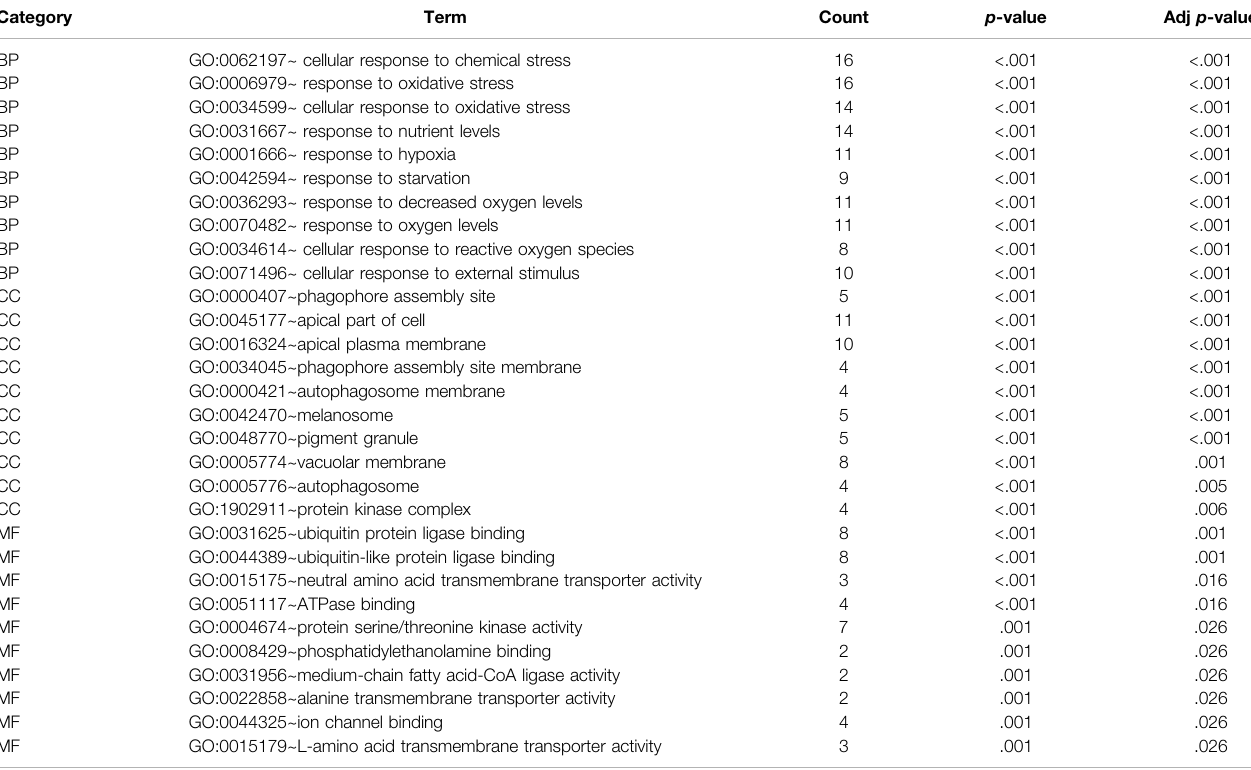
TABLE 6 | Signi fi cantly enriched GO terms of co-expression mRNA with PAAD with an adjusted p < .05 Category